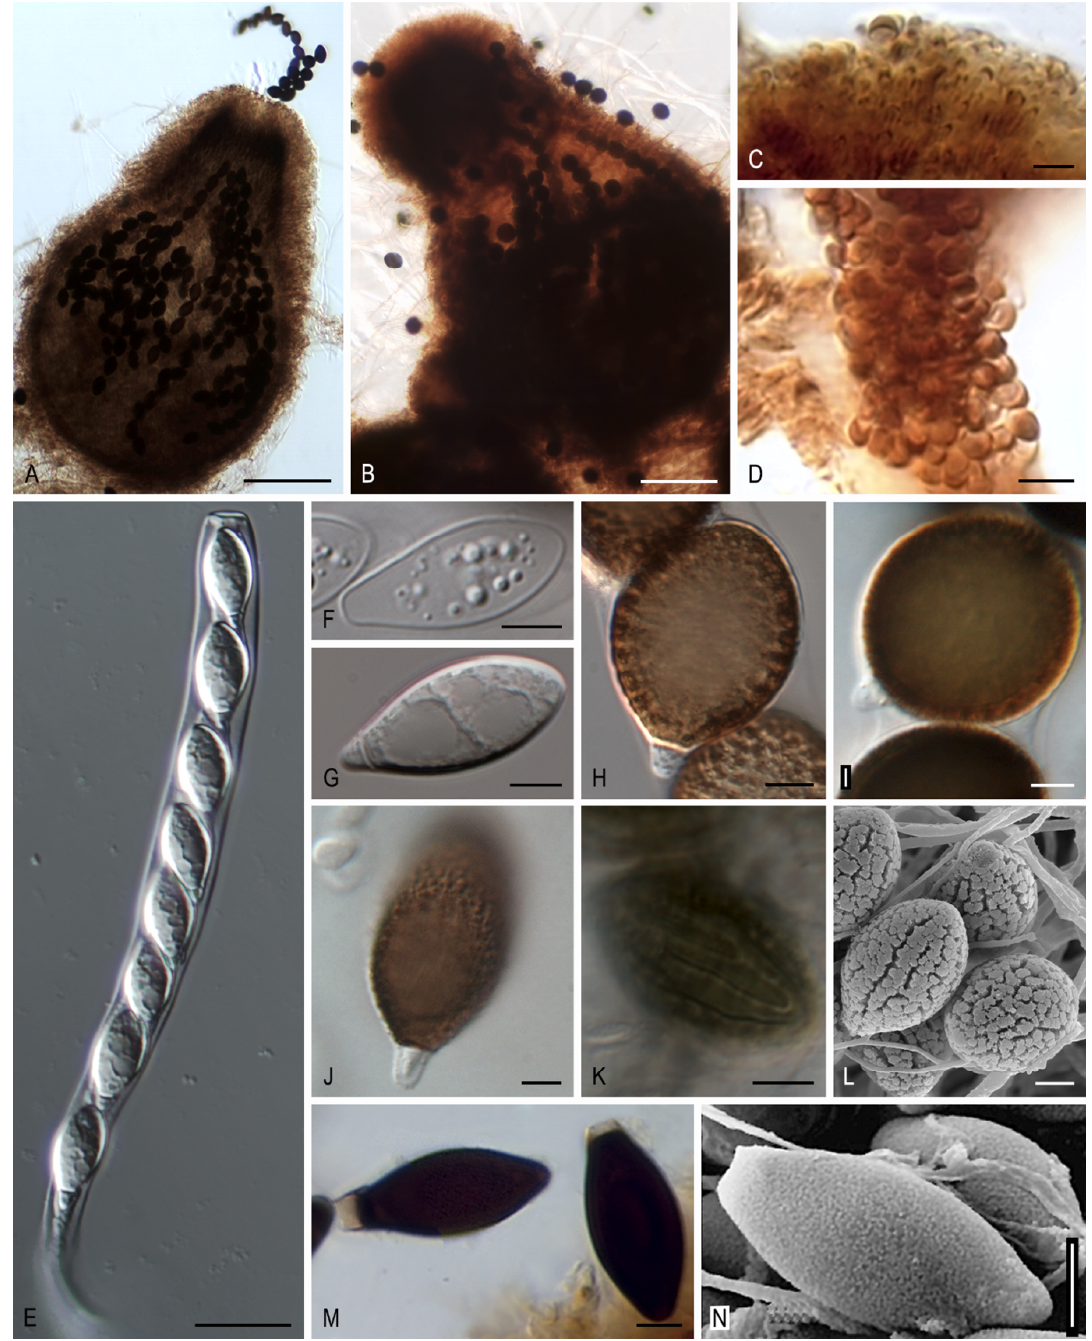
Figure 11. Morphology of Jugulospora . Ascoma. ( A ) Jugulospora rotula FMR 12428. ( B ) Jugulospora rotula FMR 12690. Detail of the papillate neck. ( C , D ) Jugulospora carbonaria ATCC 34657. Ascus. ( E ) Jugulospora rotula FMR 12428. Immature ascospores. ( F , G ) Jugulospora rotula FMR 12428. Different ascospore morphology of Jugulospora rotula . ( H ) CBS 12690. ( I ) CBS 110113. ( J ) CBS 110112. ( K , L ) FMR 12428. Ascospores. ( M ) Jugulospora carbonaria ATCC 34567. ( N ) Jugulospora antarctica IMI 381338. Bars: ( A , B ) = 100 µm; ( C , E ) = 20 µm; ( D ) = 10 µm; ( E ) = 15 µm; ( F – N ) = 5 µm. Key to species of Jugulospora .